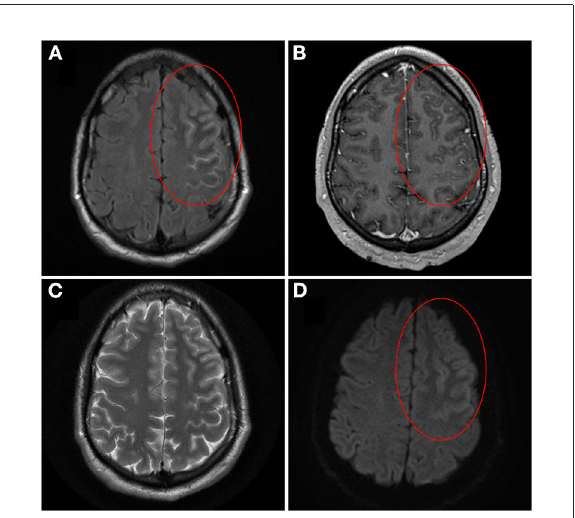
FIGURE1 Brain magnetic resonance imaging of unilateral cortical FLAIR-hyperintense Lesion in Anti-MOG-associated Encephalitis with Seizures (FLAMES)/Unilateral cerebral cortical encephalitis (UCCE). On axial T2-weighted fluid-attenuated inversion recovery (T2-FLAIR) image pre-gadolinium, cortical swelling and hyperintensity of both the left frontal cortex and adjacent sulci is seen, with hypointensity of the adjacent juxtacortical white matter [ (A) circle]. On axial T1-weighted image post-gadolinium, corresponding leptomeningeal enhancement is also seen [ (B) circle]. The cortical hyperintensity is not well visualized on axial T2-weighted image (C) . On axial diffusion-weighted image there is brightness of the cortex with sparing of the subarachnoid space [ (D) circle]. Corresponding subtle darkness on apparent diffusion coefficient map was seen, compatible with true diffusion restriction (not shown). Image adapted and re-used with permission from Springer Nature: Budhram A, Mirian A, Le C, Hosseini-Moghaddam SM, Sharma M, Nicolle MW. Unilateral cortical FLAIR-hyperintense Lesions in Anti-MOG-associated Encephalitis with Seizures (FLAMES): characterization of a distinct clinico-radiographic syndrome. J Neurol. (2019) 266(10):2481–7.